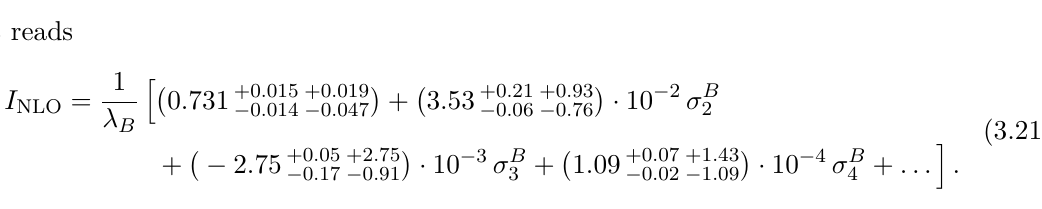
Figure 8 . Coefficients of the leading term (blue) and of 0 . 1 σ 2 (red) in the result (3.19) including scale variations added in quadrature, for different values of ¯ ω